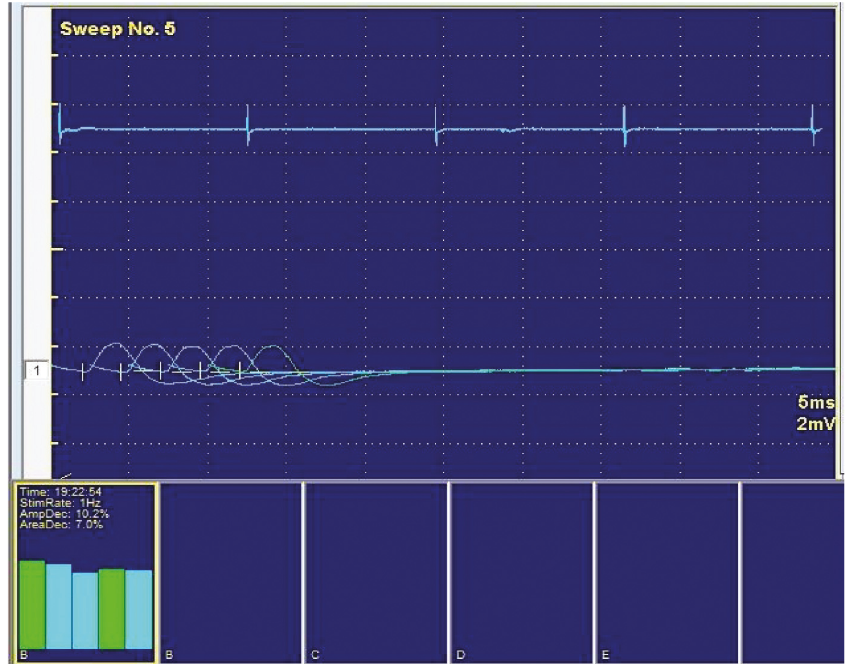
Figure 2: Decremental response of 10% seen on repetitive stimulation of the facial